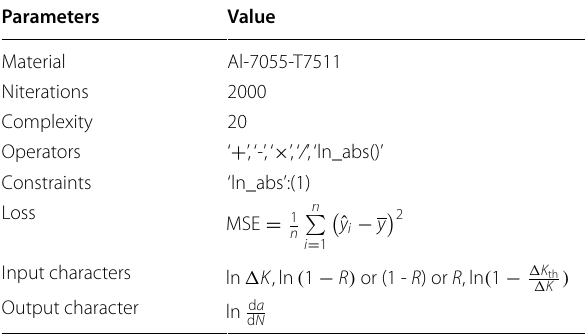
Table 2 Basic settings for PySR Parameters